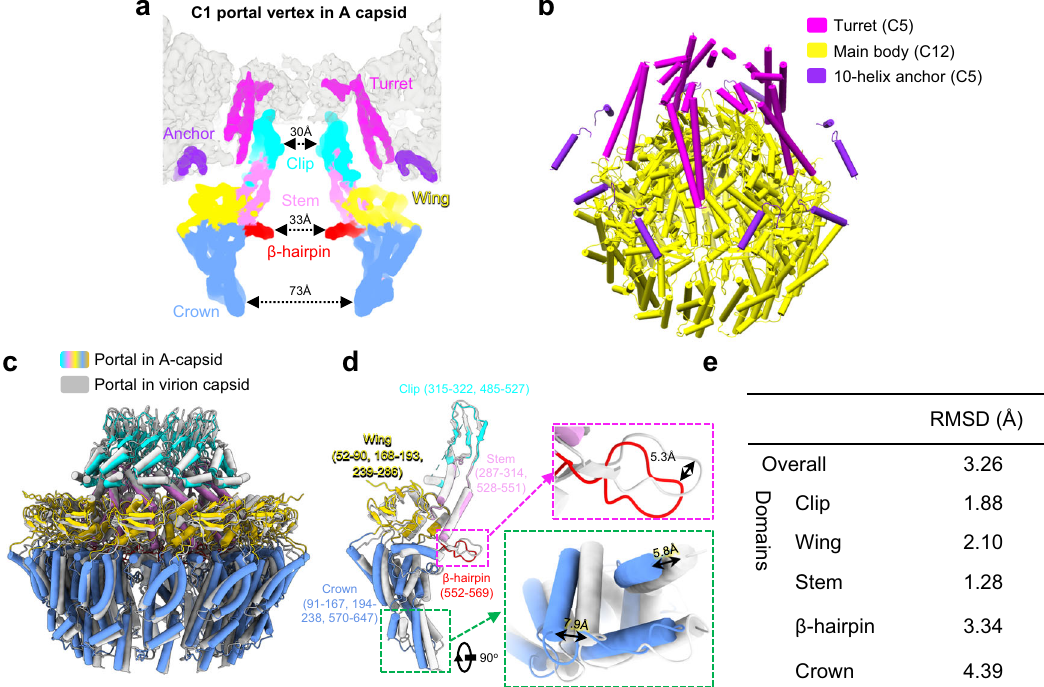
Fig. 3 | Insituportal structure of the DNA-devoid capsid.a Superposition ofthe C1 density mapof theportalvertexregion(transparent gray) withthe segmentsof theC5portalturret(magenta),C5portal10-helixanchor(violet),andtheC12portal mainbody(coloredbydomain:Clip,cyan;Stem,pink;Wing,yellow; β -hairpin,red; Crown, blue). b Pipe-and-plankdepictionof the portal.TheC5turret, the C12main body, and the C5 10-helix anchor are in magenta, yellow and violet,